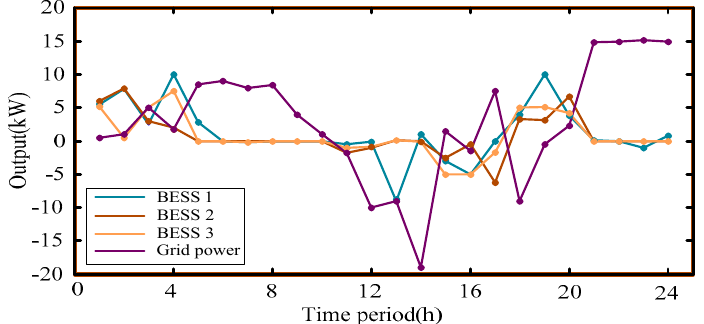
Figure 14. Energy dispatching scheme under the situation 1.